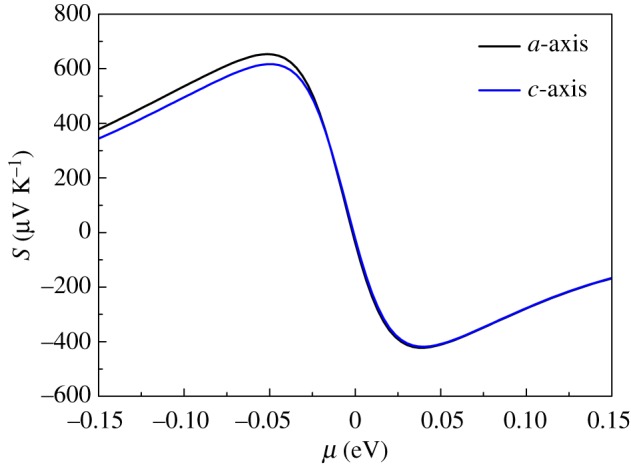
Calculated Seebeck coefficients as a function of chemical potential along the a- and c-directions for AgInTe2 at 300 K.